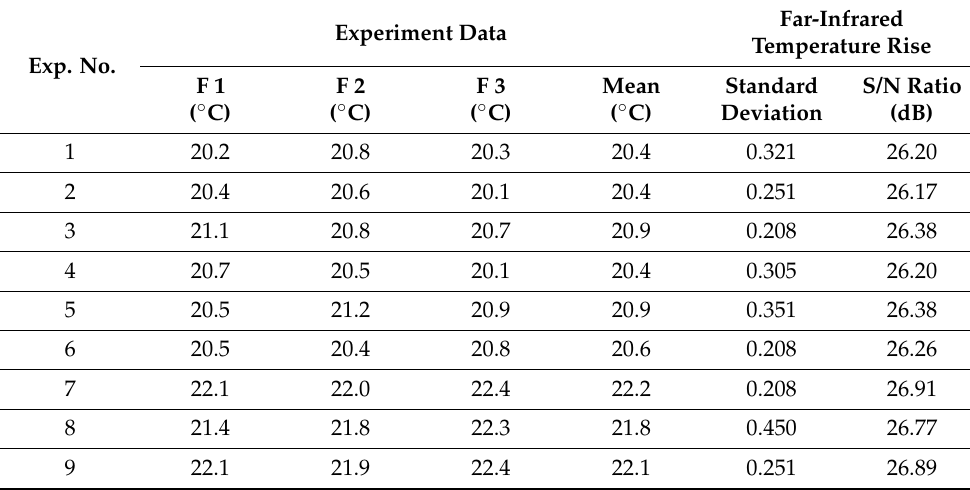
Table 19. Far-infrared temperature rise experimental data.